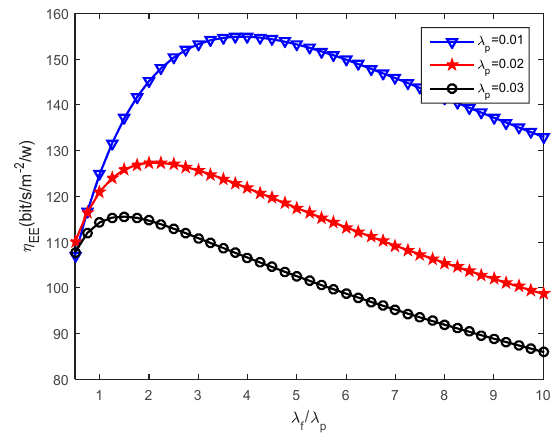
Figure 10. Energy efficiency under different picocell deployment density when T p = 6.5 dB and T f = 0.5 dB.